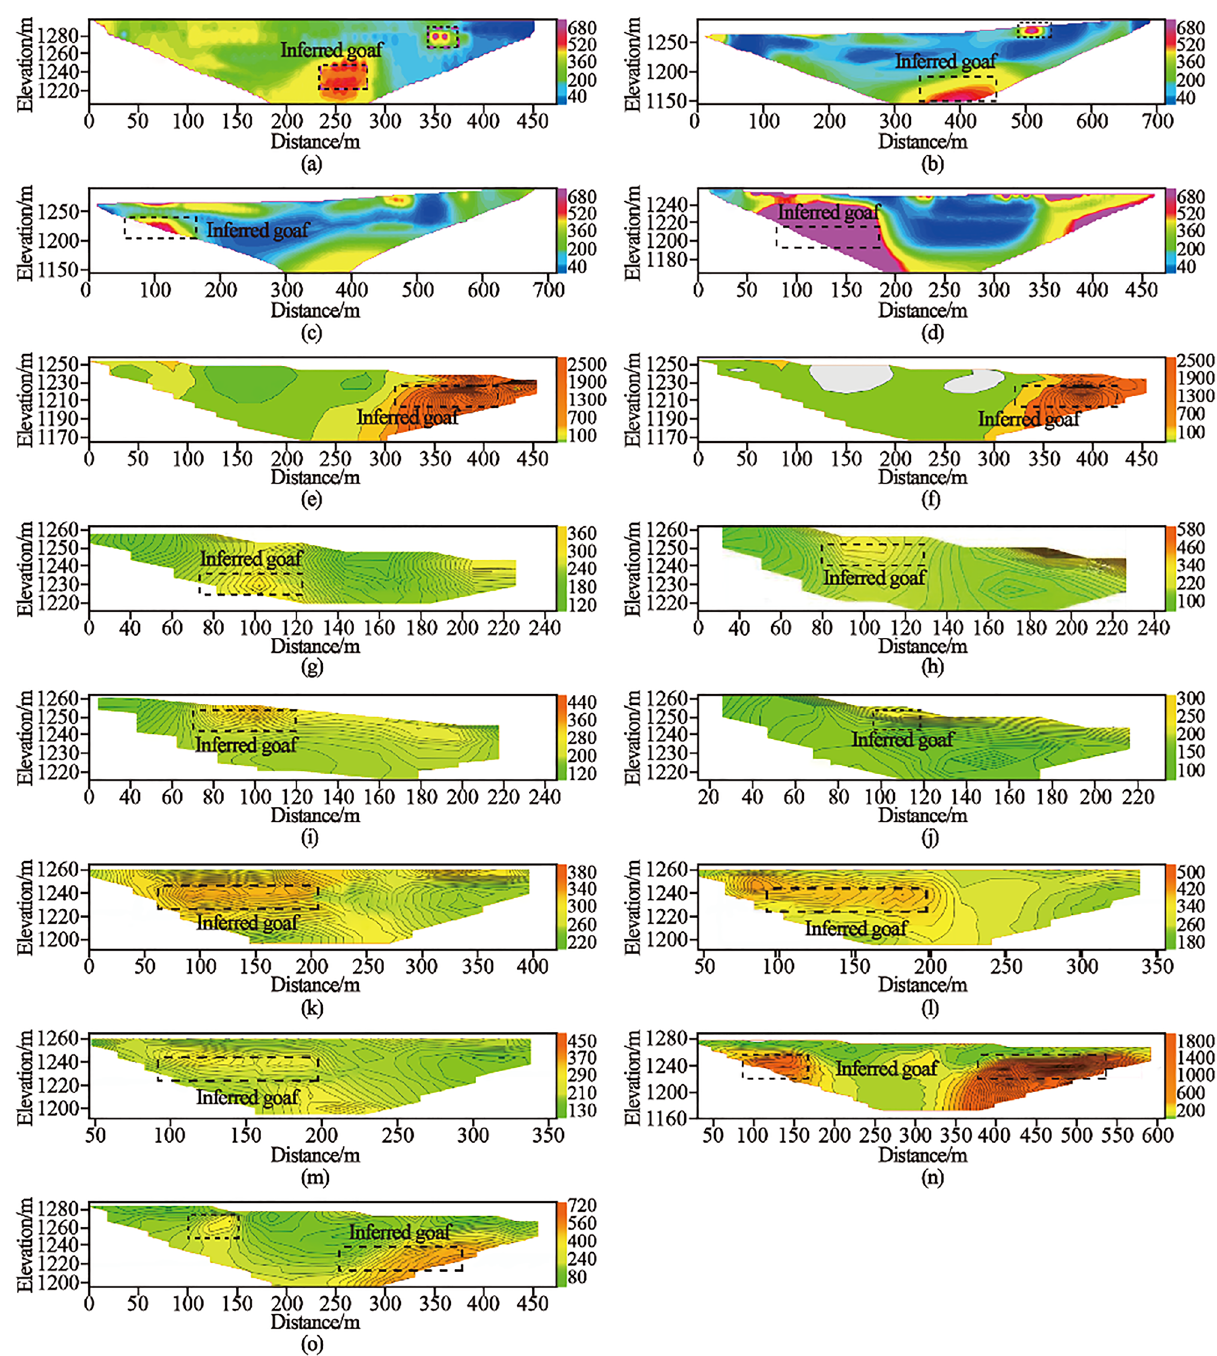
Figure 9. Typical apparent resistivity profiles of high density electrical exploration: ( a ) Apparent resistivity profile of line G0; ( b ) Apparent resistivity profile of line G3; ( c ) Apparent resistivity profile of line G4; ( d ) Apparent resistivity profile of line G5; ( e ) Apparent resistivity profile of line G11; (f) Apparent resistivity profile of line G12; ( g ) Apparent resistivity profile of line G13; ( h ) Apparent resistivity profile of line G14; ( i ) Apparent resistivity profile of line G15; ( j ) Apparent resistivity profile of line G16; ( k ) Apparent resistivity profile of line G17; ( l ) Apparent resistivity profile of line G18; ( m ) Apparent resistivity profile of line G19; ( n ) Apparent resistivity profile of line G20; ( o ) Apparent resistivity profile of line G21. The outline in the profiles show the location of the inferred